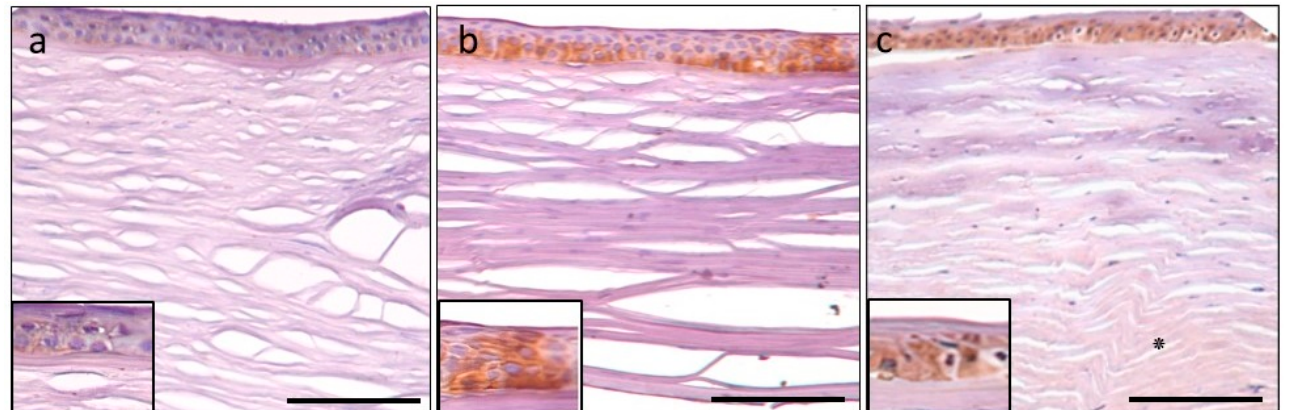
Figure 5. Matrilin-2 immunohistochemistry. Control cornea with minimal immunopositivity in the epithelium and endothelium and unstained stroma ( a ). Moderate epithelial immuno-expression in PBK and the rest of the tissue is unstained ( b ). FECD specimen also disclosed moderate epithelial staining and minimal stromal positivity is present in the posterior area (asterisk) ( c ). Epithelial signal intensity (insets). Scale bar refers to 100 µm.